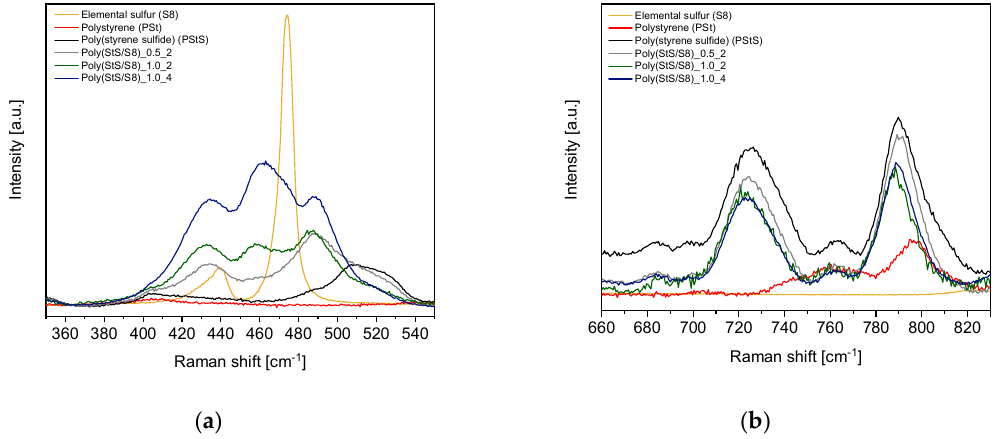
360 380 400 420 440 460 480 500 520 540